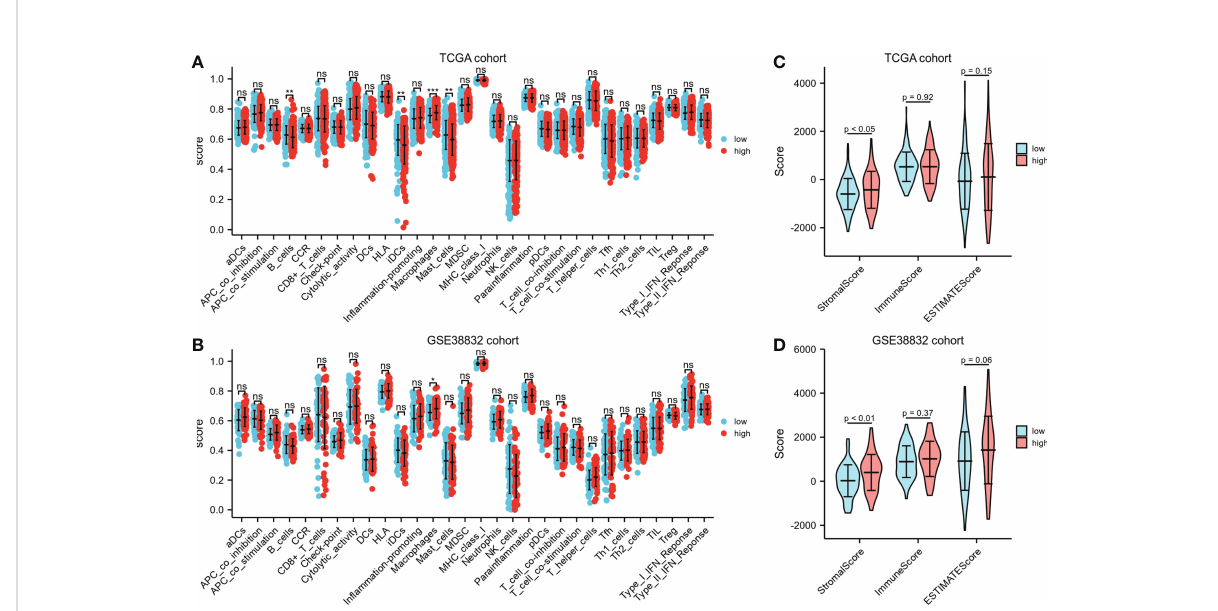
FIGURE 6 Immunological features annotation of the signature. (A, B) The in fi ltration levels of immune cell components between the two risk groups in TCGA CRC cohort and GSE38832 cohort. (C, D) Stromal score, immune score and ESTIMATE score calculated by ESTIMATE algorithm in TCGA CRC cohort and GSE38832 cohort. * P < 0.05, ** P < 0.01, *** P < 0.001, ns, no signi fi